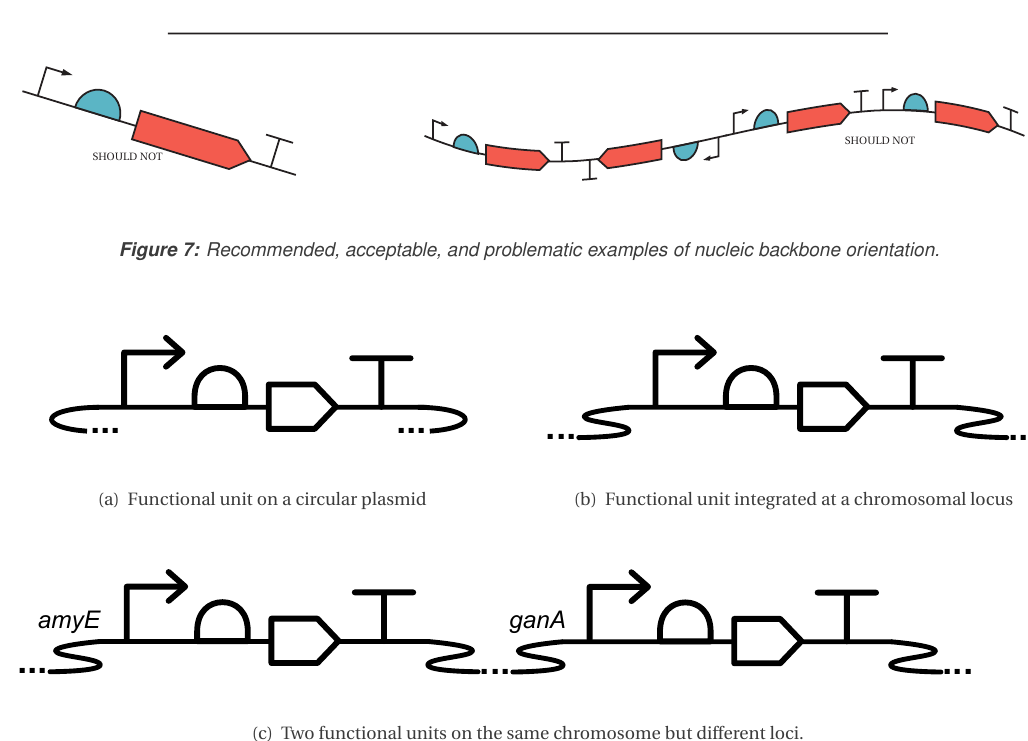
Figure 8: Examples of RECOMMENDED indication of genomic context.